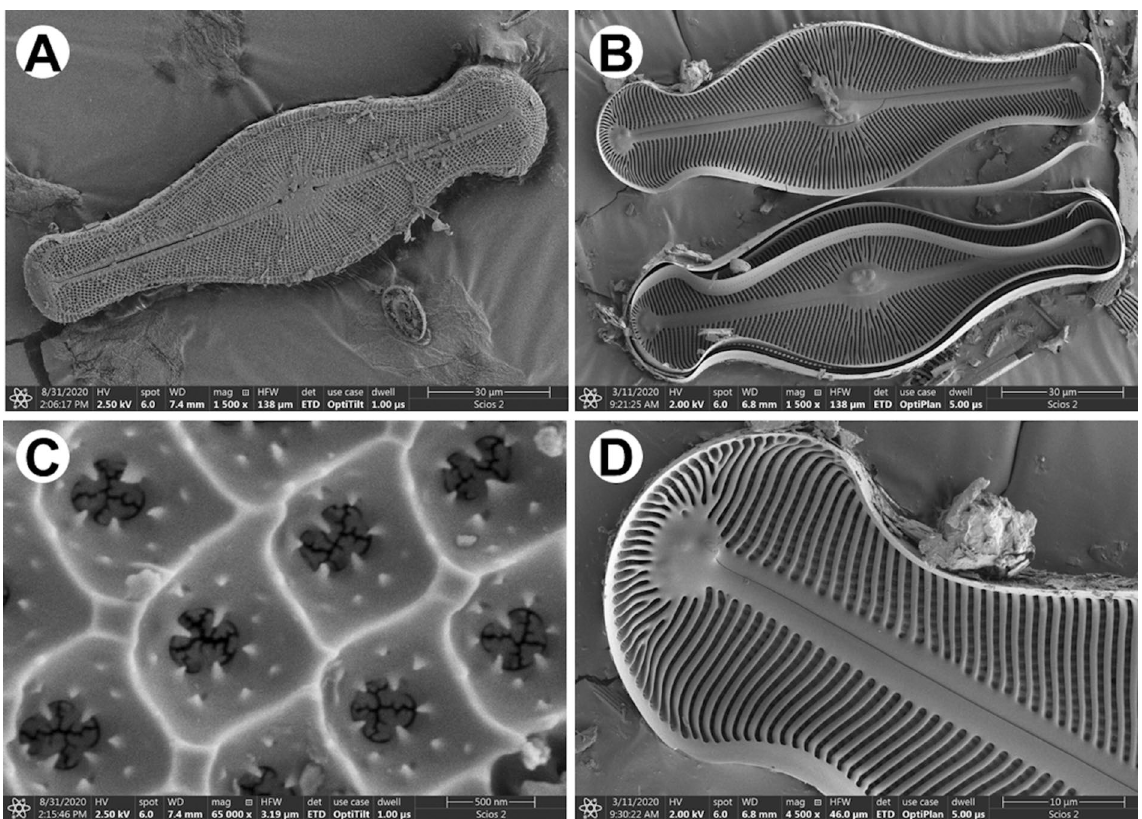
Figure 4. SEM images of Didymosphenia geminata frustule: ( A ) valve view; ( B ) inner side of the valve; ( C ) close up of the valve view—note the areolae openings; ( D ) magnification of the inner side of the valve—head